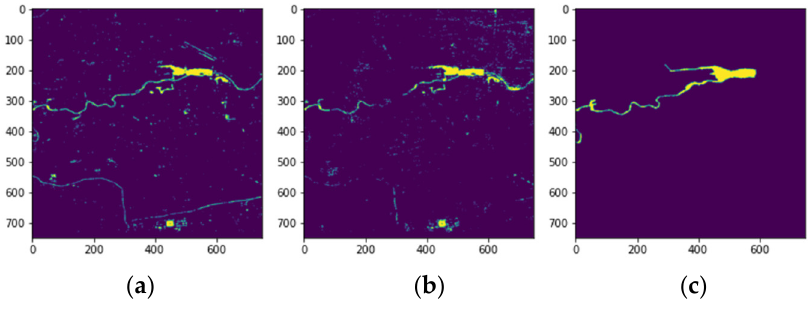
Figure 8. Water body distribution. ( a ) GLC_FCS30; ( b ) FROM_GLC; ( c ) CNLUCC.